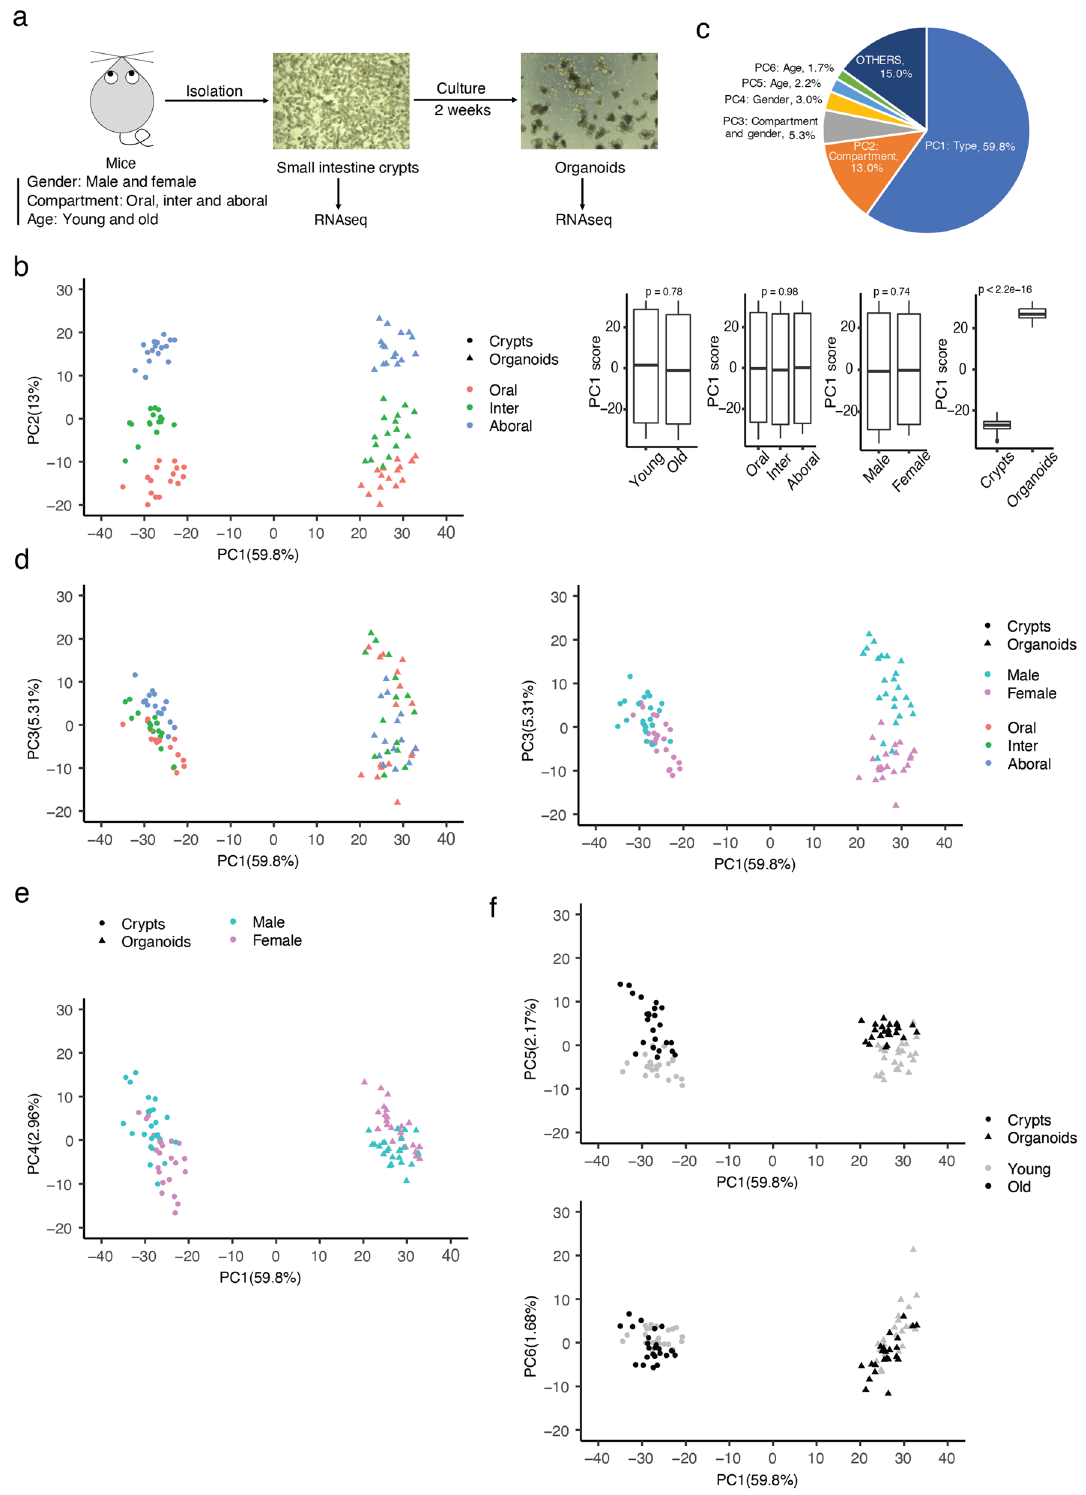
Figure 1. In vitro culturing of intestinal crypts as organoids does substantially affect their transcriptional program. ( a ) Graphic scheme for experiment design. ( b ) Point plot of the first two principal components (left panel) from PCA which were mapped to sample types (crypts and organoids) and compartments (oral, inter, aboral) separately. Boxplot of PC1 versus different biology variables indicated the main difference coming from sample types (right panels). P-value is calculated by Welch’s two-tail t-test. ( c ) Pie chart indicating the variance explanation percentage of top few principal components deconvoluted from meta RNA-seq. ( d ) Point plot of PC3 versus PC1 by mapping PC3 to different groups of compartments (top panel) and gender (bottom panel). ( e ) Point plot of PC4 versus PC1 by mapping PC4 to different groups of gender. ( f ) Point plot of PC5 (left panel) and PC6 (right panel) versus PC1 by mapping PC5/ PC6 to different groups of age. See also Supplementary Figs.